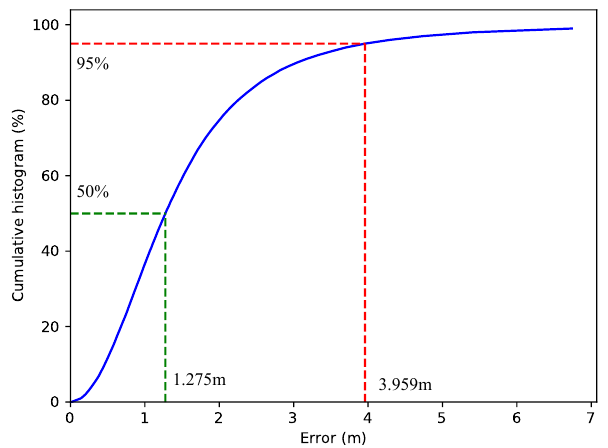
Figure 3. The error-cumulative histogram of the proposed MLP-mmWP method (employing se- quences of seven BFFs and with a noise level of σ = 6 dB). The green dotted line is the median error and the red dotted line represents the 95th percentile error.